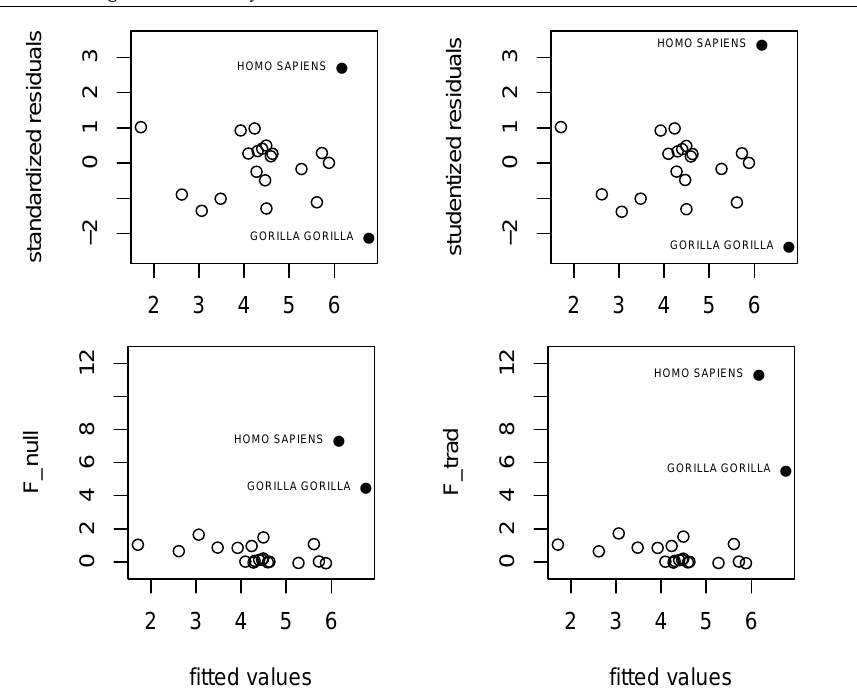
Figure 3 – Standardized and studentized residuals vs. fitted values for the primates data (top row) and their squared counterparts (bottom